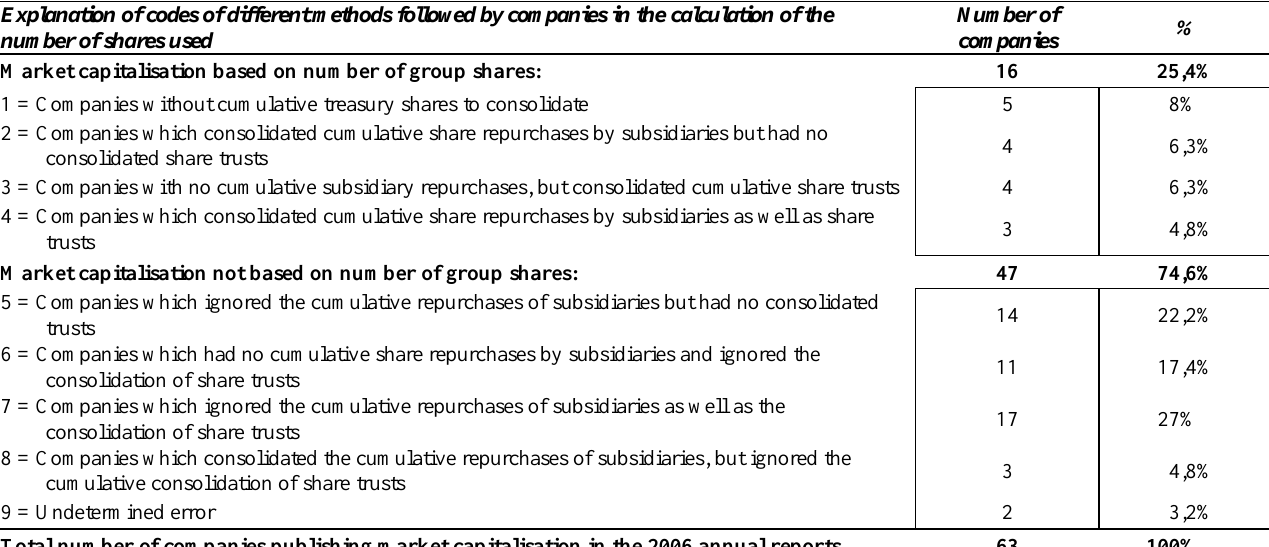
Table 1. Summary of companies publishing market capitalisation in 2006 annual reports Explanation of codes of different methods followed by companies in the calculation of